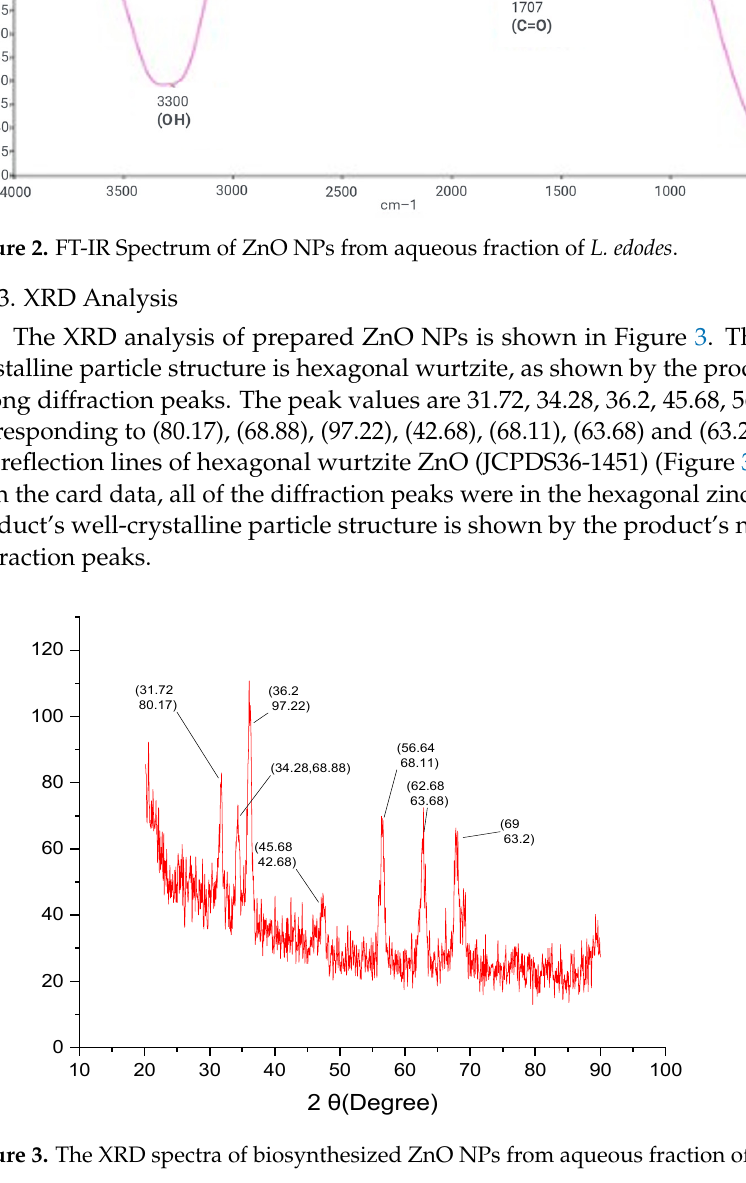
Figure 1. UV-Vis spectrum of ZnO NPs and L. edodes aqueous fraction.